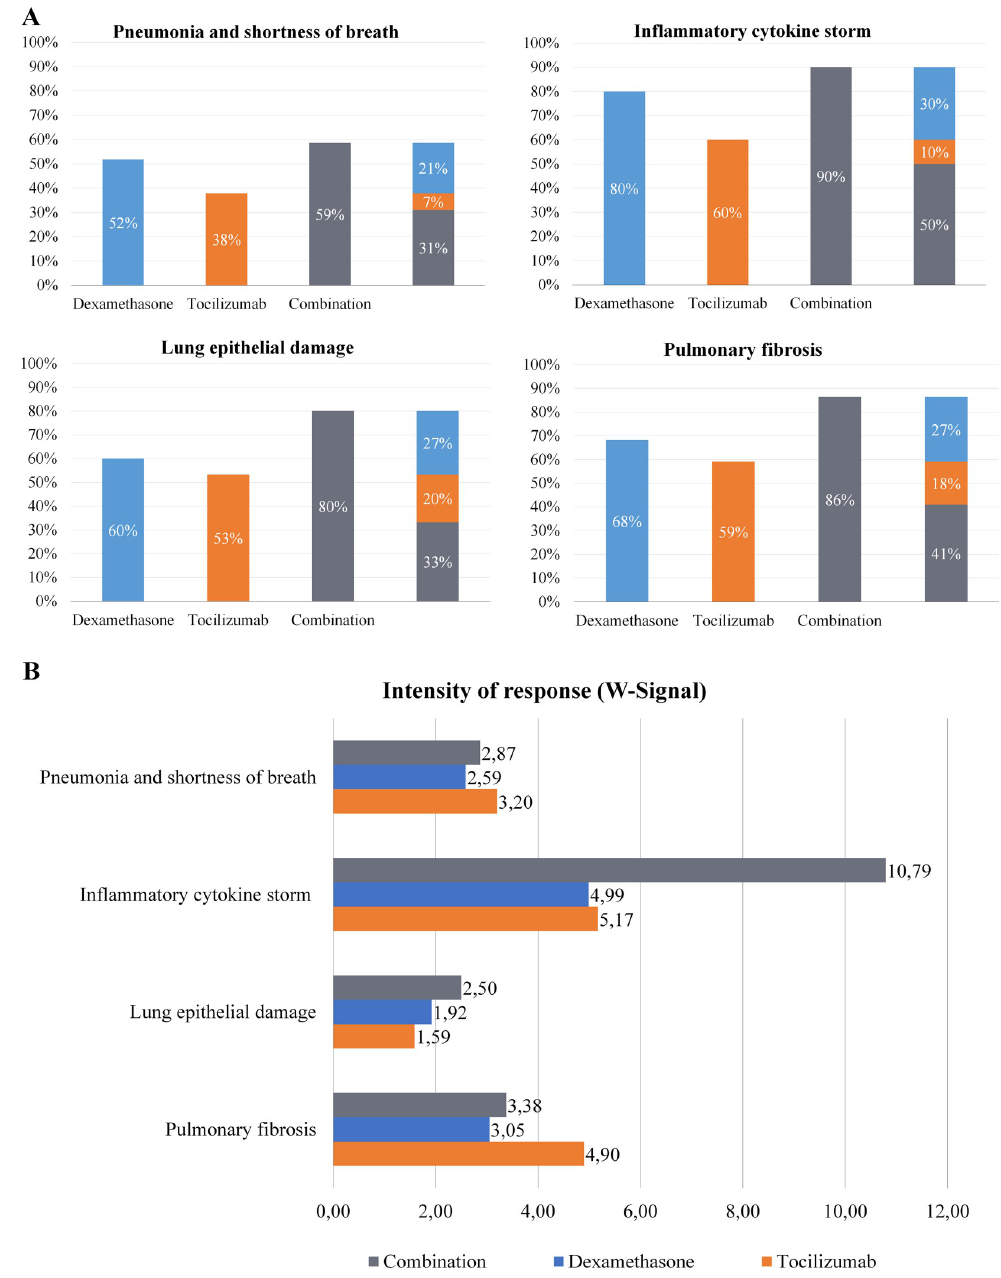
Fig 6. Impact of dexamethasone and tocilizumab over COVID-19 evoked ARDS pathophysiological motives. (A) Percentage of altered effectors reversed by each drug in each specific COVID-19 evoked ARDS motive. (B) Intensity of response (W-Signal) to each drug and the combination in the COVID-19 evoked ARDS specific motive, according to the simulated